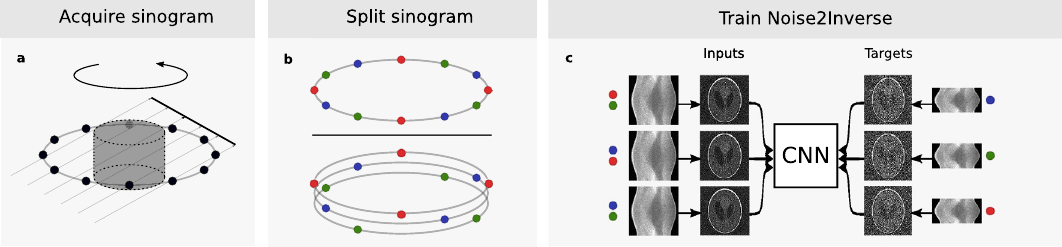
Figure 2. Noise2Inverse for single-slice parallel-beam tomography. ( a ), A sinogram is acquired of a rotating object. ( b ), The sinogram is split into sections (red, green, and blue) in the domain of the rotation angle. ( c ), The input and target images for training the network are reconstructed from distinct sections of the sinograms (indicated by the red, green, and blue dots). The input and target sections cover